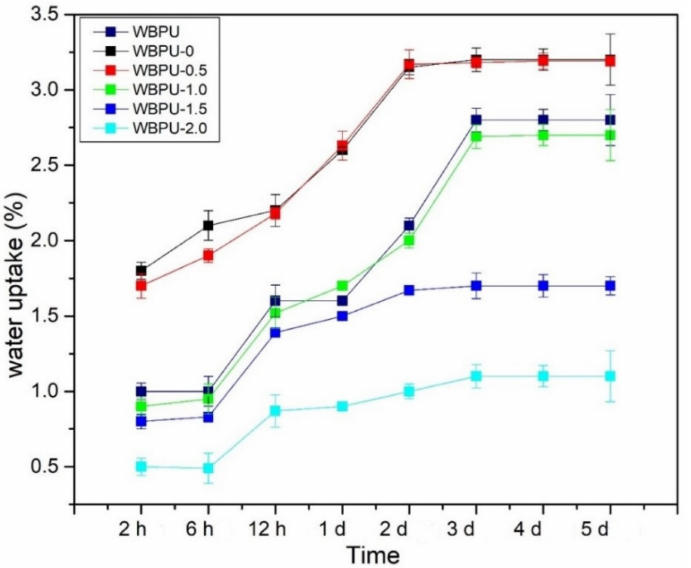
Figure 9. Water Uptake of WBPU, WBPU-0, WBPU-0.5, WBPU-1.0, WBPU-1.5 and